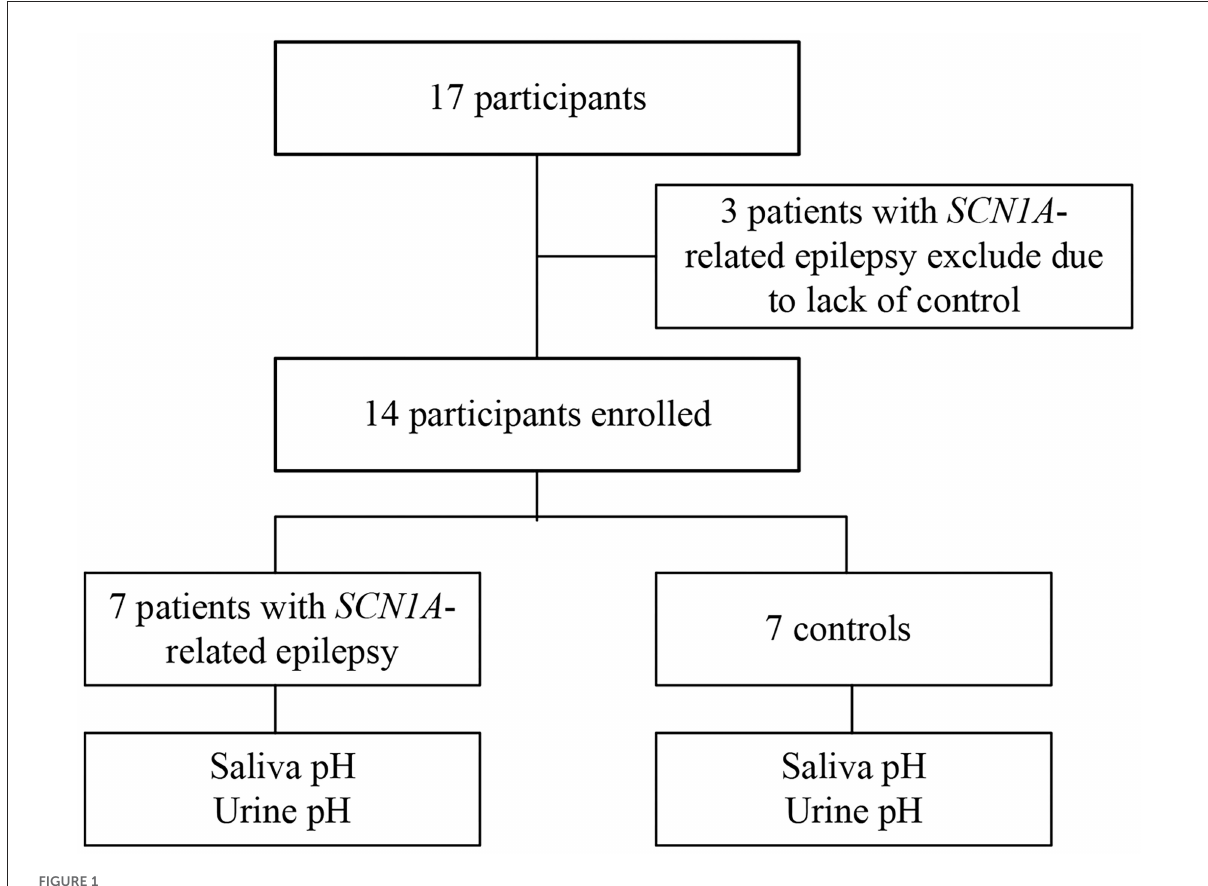
FIGURE1 Flow diagram of study participants.